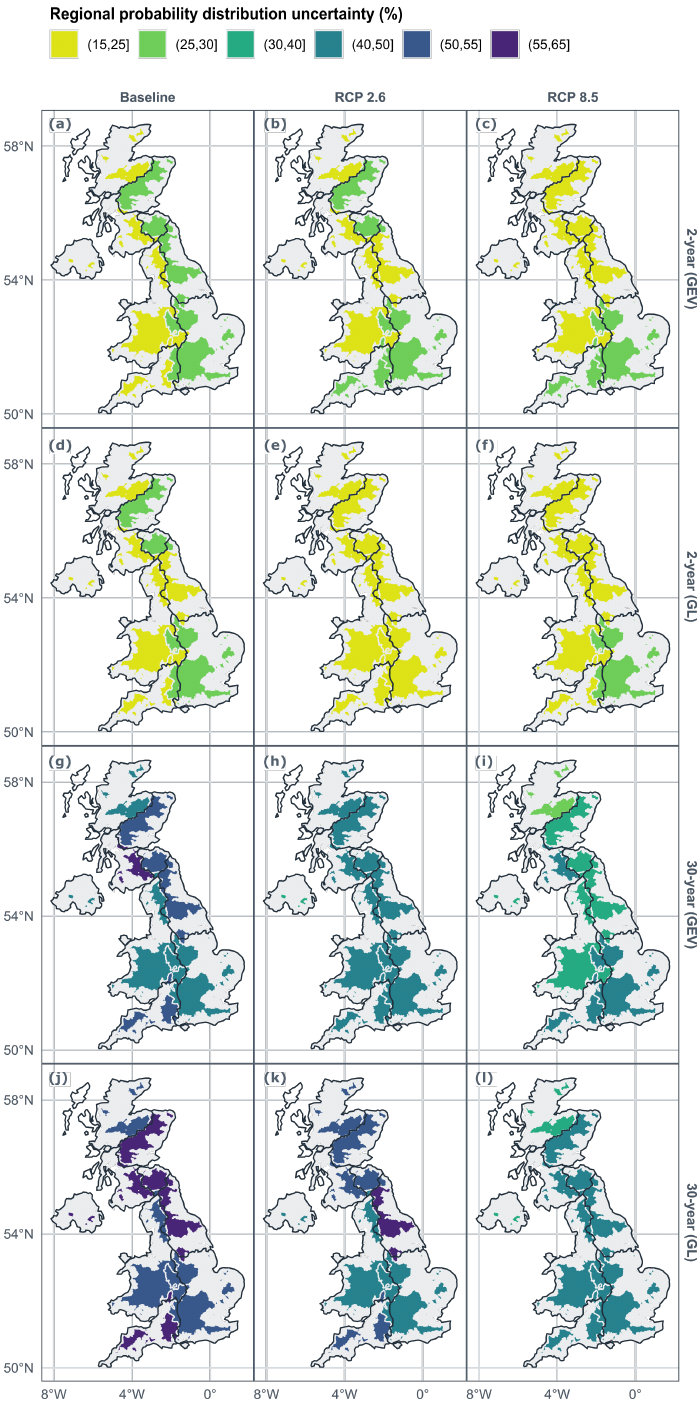
Figure 6. Regional probability distribution uncertainty (PDU) across the UK for the ( a ) 1:2-year RP using GEV over the baseline; ( b ) 1:2-year RP using GEV over the 2080s under RCP 2.6; ( c ) 1:2-year RP using GEV over the 2080s under RCP 8.5; ( d ) 1:2-year RP using GL over the baseline; ( e ) 1:2-year RP using GL over the 2080s under RCP 2.6; ( f ) 1:2-year RP using GL over the 2080s under RCP 8.5; ( g ) 1:30-year RP using GEV over the baseline; ( h ) 1:30-year RP using GEV over the 2080s under RCP